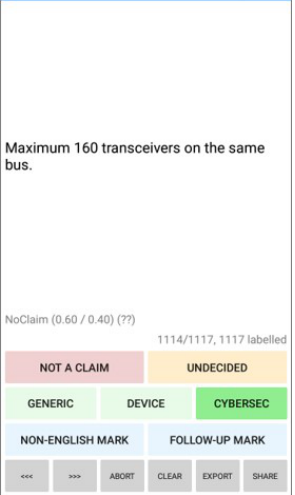
Figure 6. A snapshot of the manual labeling mobile